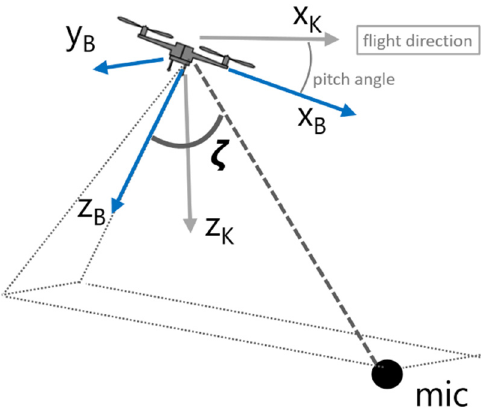
Figure 1. Multicopter in forward flight with the body-fixed and kinematic frames indicated by subscripts B and K, respectively. The radiation angle ζ is defined as the angle between the body-fixed z -axis and the line connecting the source and receiver.